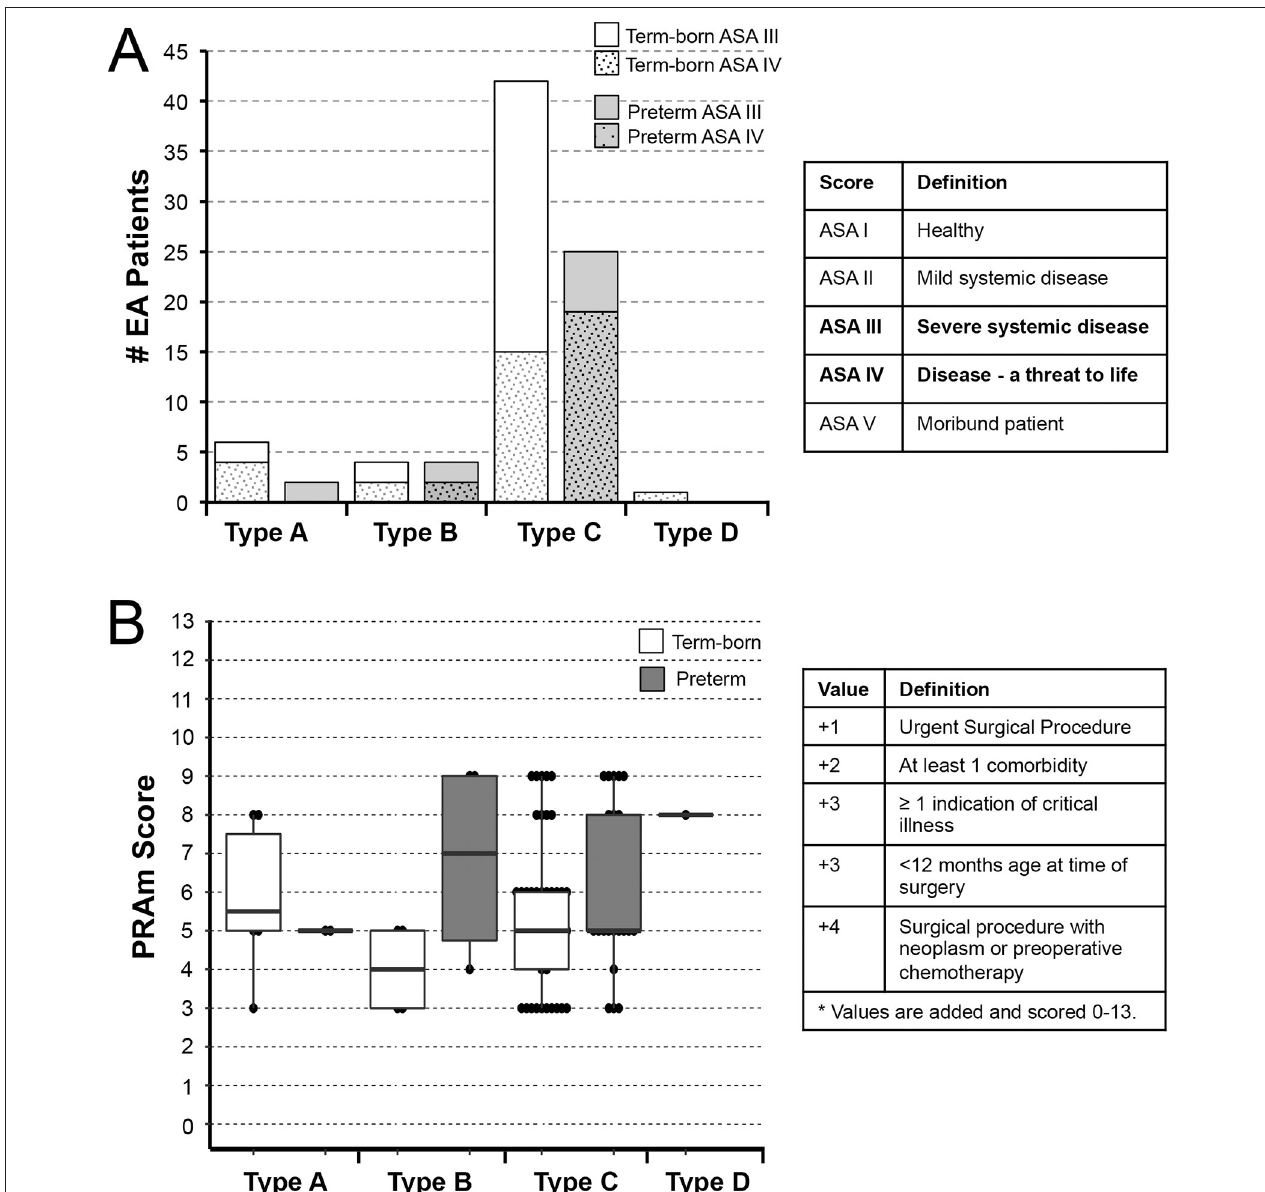
FIGURE 3 | Underlying Disease Severity Stratification in Esophageal Atresia Cohort. Graphs illustrate incidence of American Society of Anesthesiologists (ASA) Physical Status classification (A) and Pediatric Risk Assessment (PRAm) severity scores (B) in infants born with esophageal atresia (EA) that underwent primary repair at a single institution from 2009-2020 ( n = 84). Definition of scoring is shown in summary tables on the right for both the ASA Physical Status (16) and PRAm scoring (17–19). Graphs show stratification by anatomical types of EA (type A-D) and gestational age (term-born and premature; see Methods section). Specifically, all patients in this study were rated as either ASA Physical Status III or IV (A) . For the most common type C EA, the majority of term-born patients had ASA III status (27/42; 64%), while the majority of premature infants were assigned ASA IV status (19/25; 76%) implicating premature infants were more critically ill in the most common type of EA, type C . Graph in (B) illustrates distribution of PRAm scores per anatomical type and gestational age. Considering all infants had surgery when < 12 months of age, the minimal score was 3. Since none of the infants had co-existing malignancy, the highest score was 9. From the graph in (B) , one can infer that premature infants had higher median score for type B EA, but lower median score for type C (thick horizontal line). Individual values are represented as dots, boxes span the interquartile range (IQR) (first and third quartile), and whiskers represent maximum and minimum values.